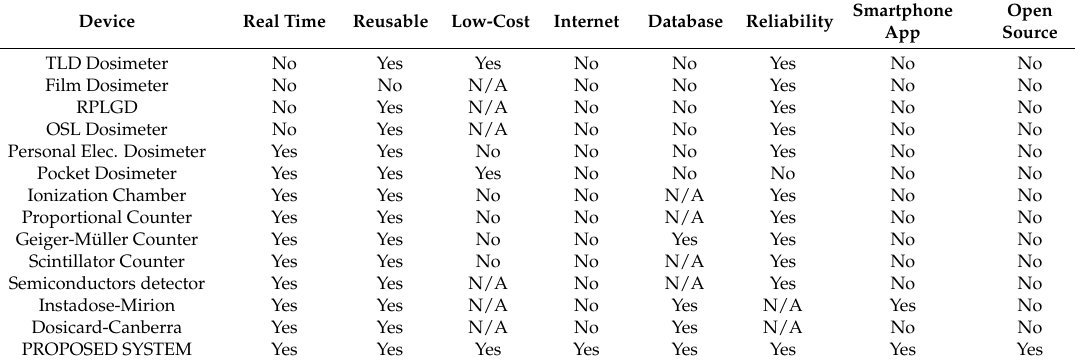
Table 4. Comparison among different dosimeters including our system.